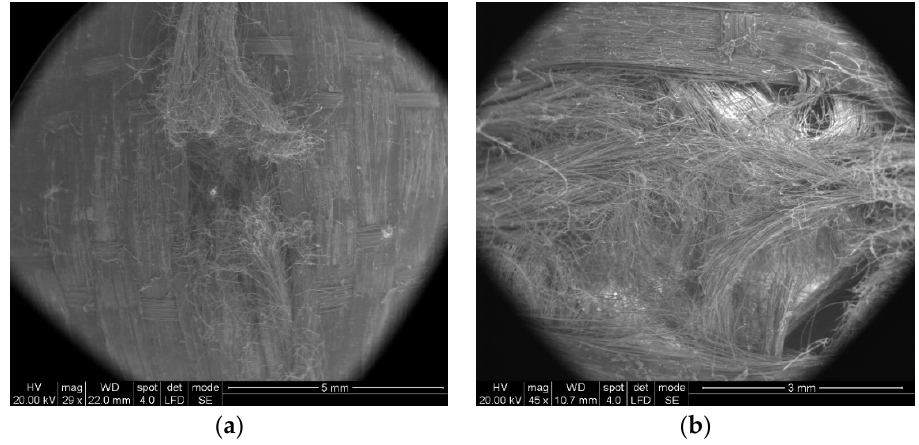
Figure 13. Aspect of broken yarns from the ballistic protection package made of LFT SB1plus: ( a ) face of layer 1 (fire 1); ( b ) face of layer 2 (fire 1).